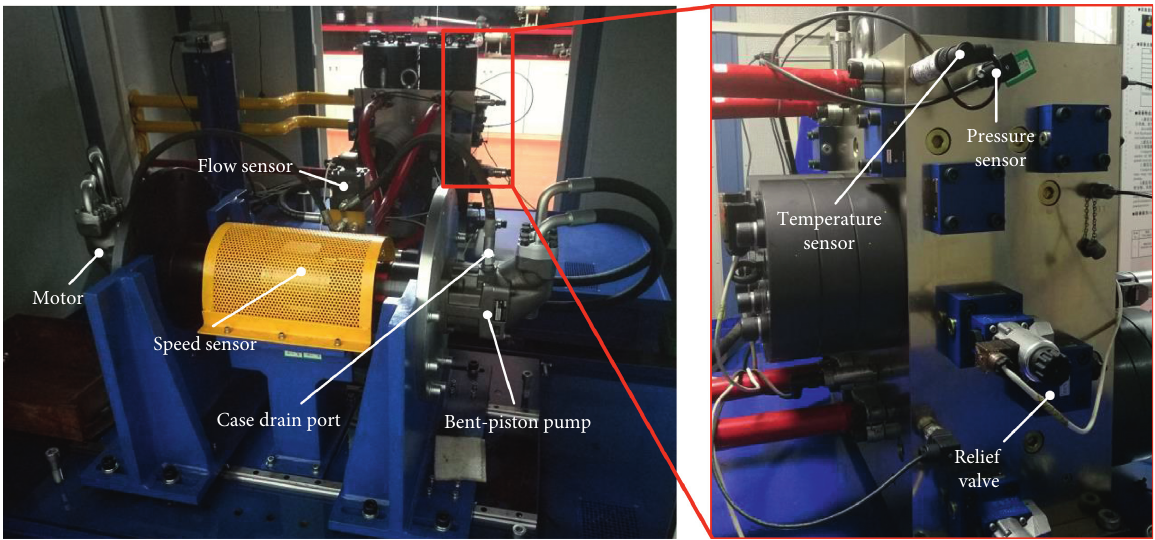
Figure 15: Photograph of the test rig. Table 2: The main parameters of the test rig.